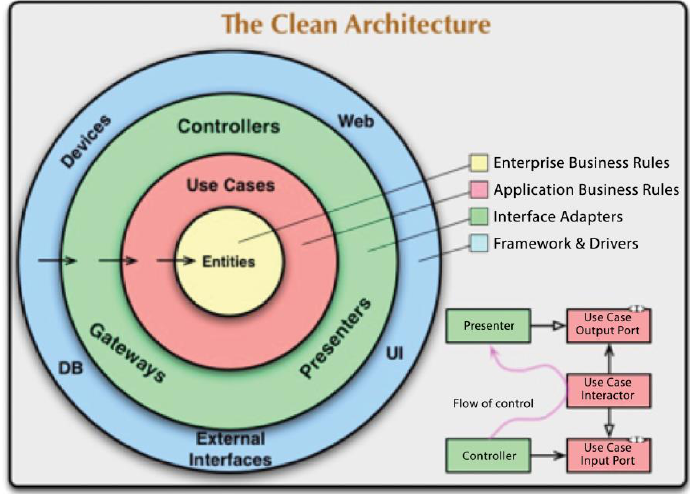
Figure 10. Descriptive diagram of clean architecture [36].